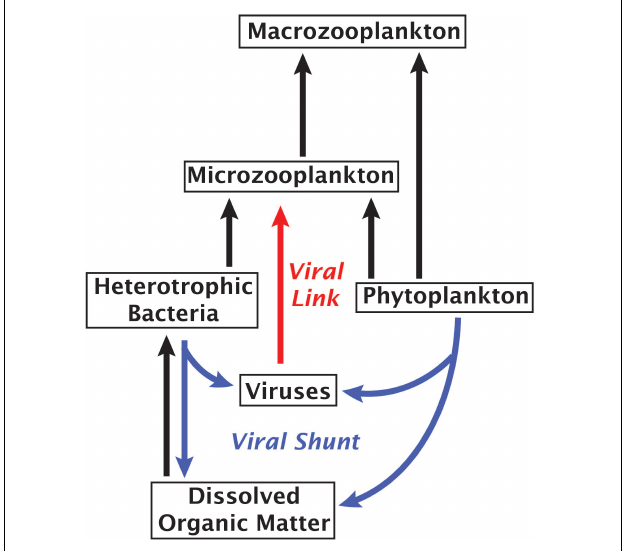
FIGURE 4 | Marine microbial food web with arrows indicating the flow of carbon. Red arrow highlights the proposed role of viruses as a link between viruses and phagotrophic